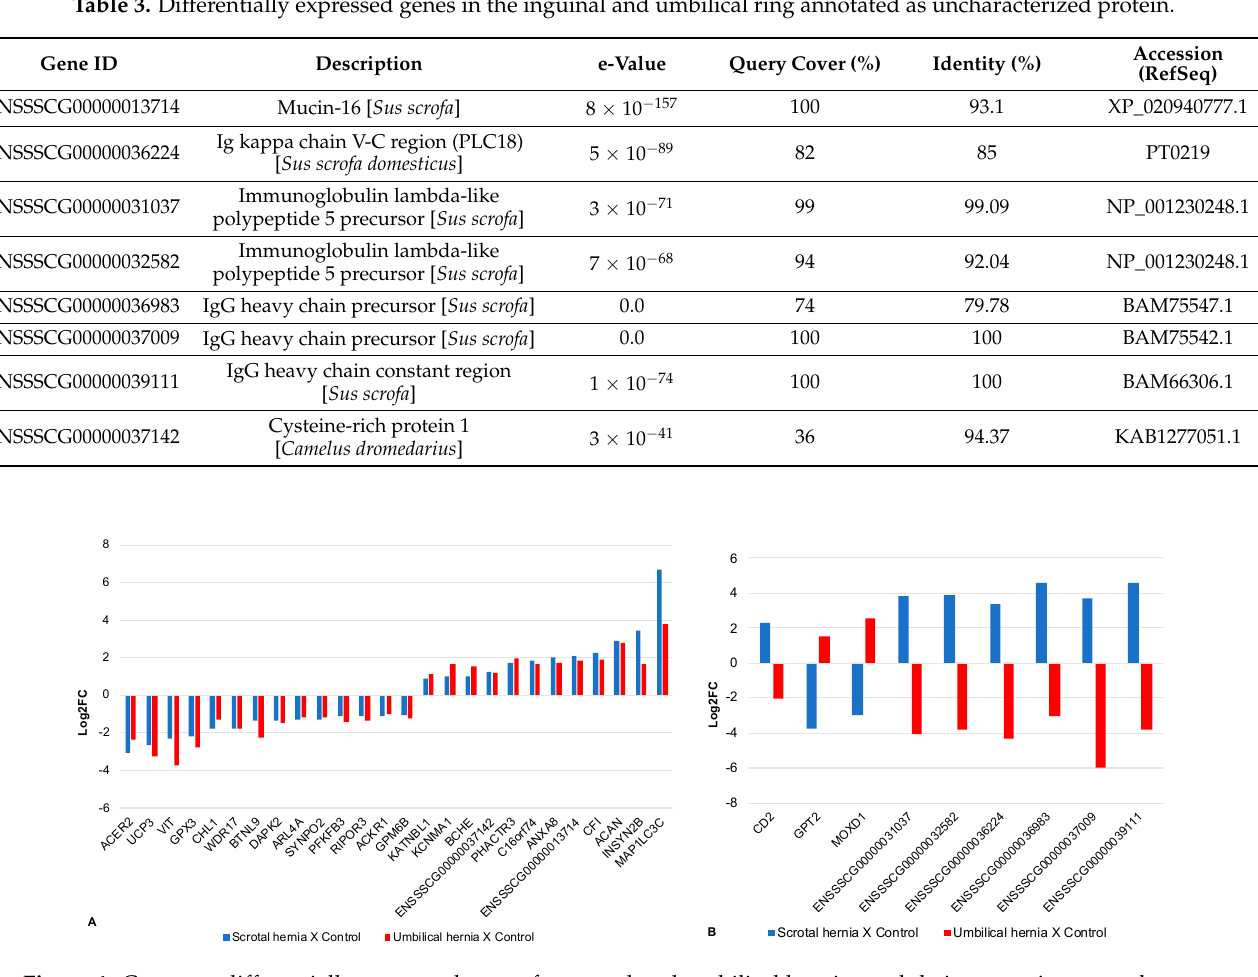
Figure 4. Common differentially expressed genes for scrotal and umbilical hernias and their respective control groups. Legend: ( A ) Genes with similar expression profile and ( B ) with opposite expression profile in the two types of hernia based on the Log2 Fold Change (log2FC).